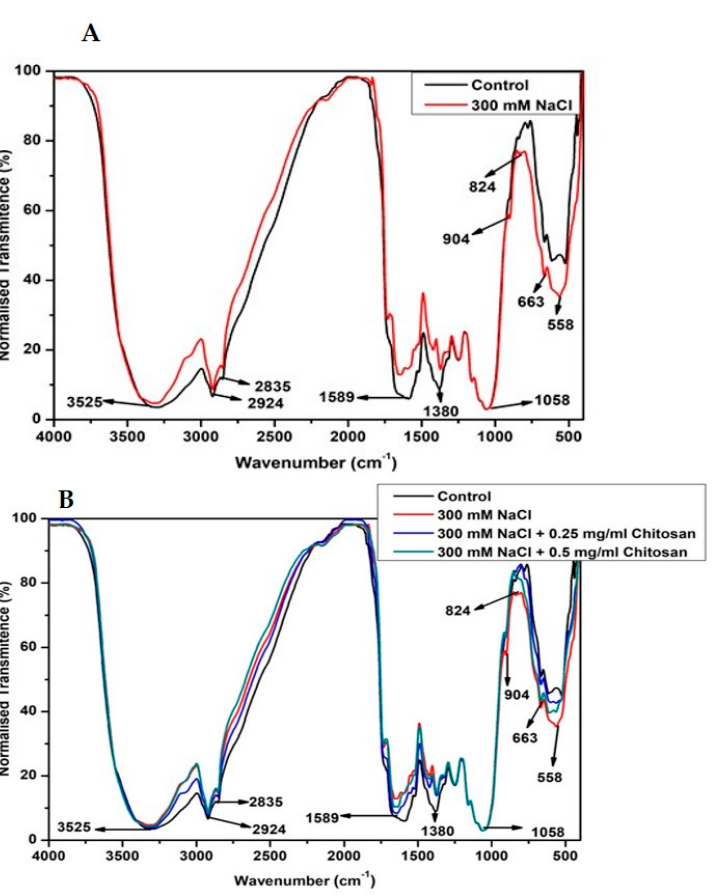
Figure 5. FTIR spectra analysis of the effect of chitosan on biomolecules in sorghum plants under salt stress. ( A ) Control (0 mM NaCl) represented as the black line and salt (300 mM NaCl) treated plants, represented as the red line, ( B ) salt-treated plants supplemented with 0.25 mg/mL (blue) and 0.5 mg/mL (green) chitosan.